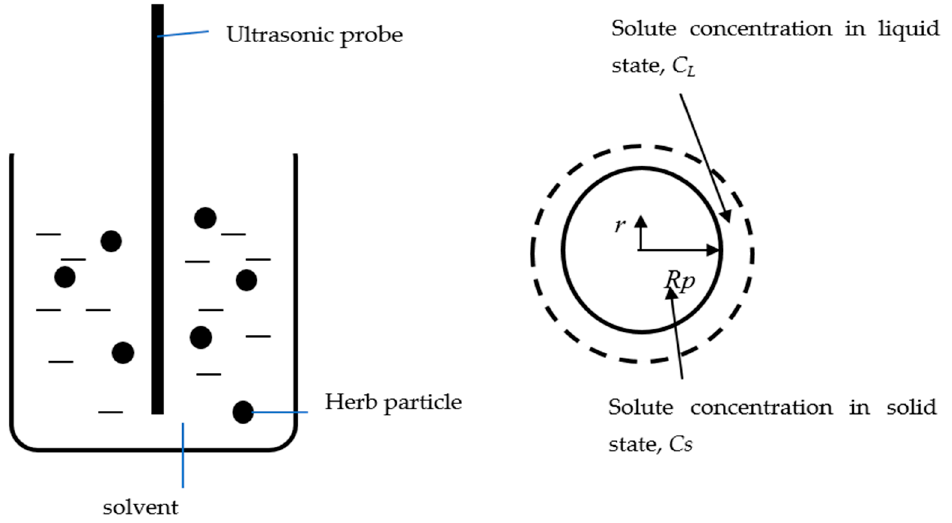
Figure 2. Schematic diagram of extraction process and solid.